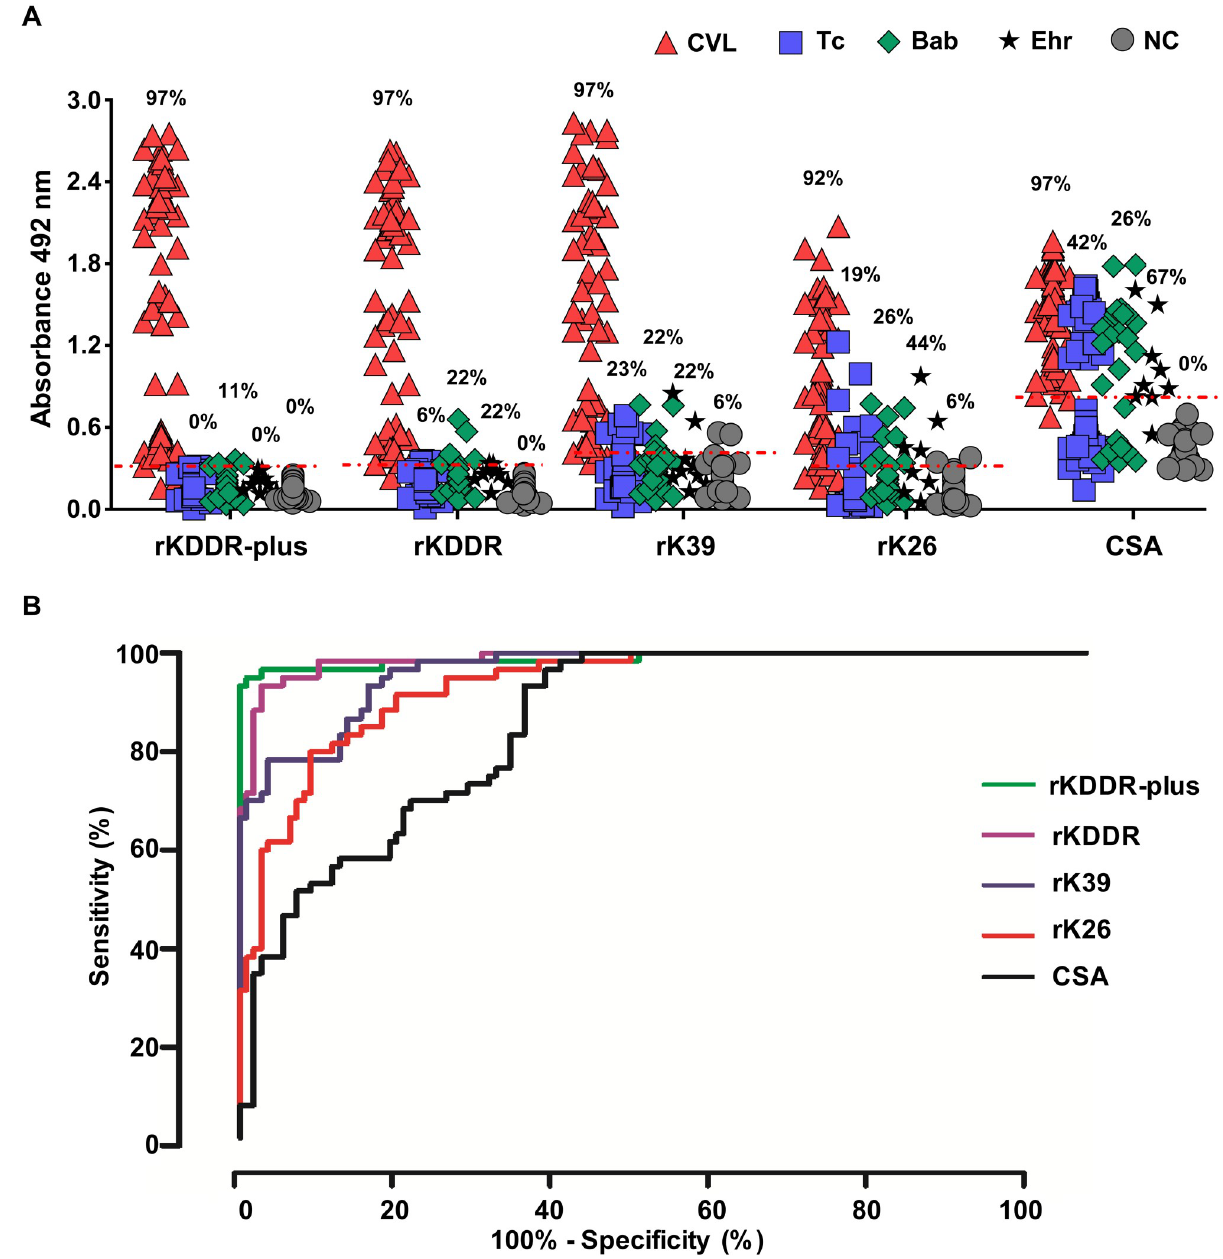
Fig 3. Evaluation of the recombinant antigens and L . infantum crude extract for the serodiagnosis of canine visceral leishmaniasis (CVL). (A) Comparison of the performance of ELISA with the rKDDR-plus, rKDDR, rK39 and rK26 antigens and the crude soluble antigen (CSA) was performed using canine sera from the following groups: dogs infected with Leishmania (CVL, n = 60); non-infected healthy dogs (NC, n = 36); dogs naturally infected with Babesia sp. (Bab, n = 27) and Ehrlichia sp. (Ehr, n = 9); and dogs experimentally infected with T . cruzi (Tc, n = 48), for cross-reactivity assessment. The dashed red line represents the cut-off determined by the ROC curve of each test. The index above each column in the plot indicates the percentage of samples that are above the cut-off. (B) Analysis of ROC curve of each canine serological test obtained for ELISA using rKDDR-plus, rKDDR, rK39 and rK26 antigens and the CSA. The sensitivity, specificity and area under the curve (AUC) were determined by ROC curve.